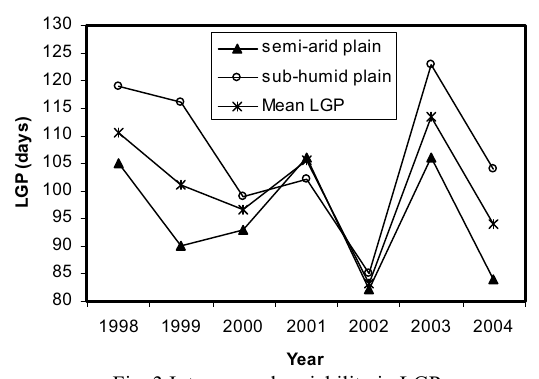
Fig. 3 Inter-annual variability in LGP